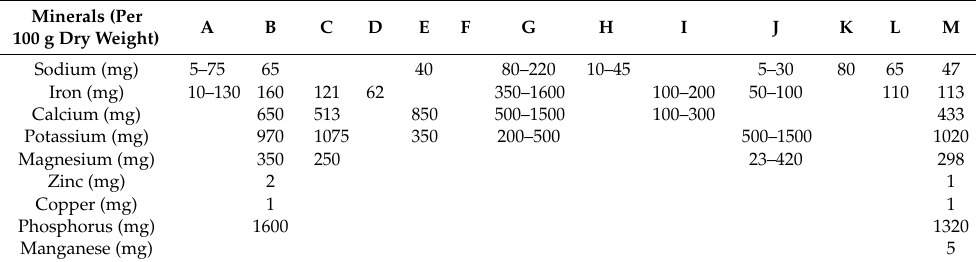
Table 4. Mineral content of 13 commercially available Chlorella